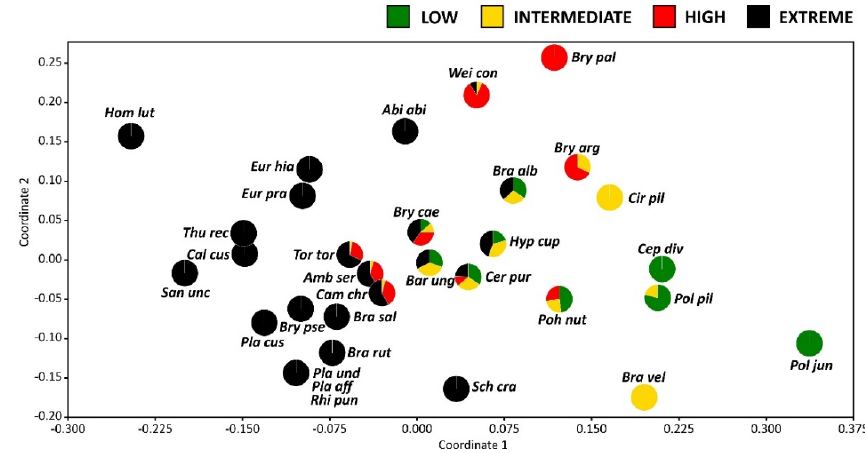
Figure 5. Non-metric multidimensional scaling (NMDS) scatterplot presenting similarities in terms of bryophyte species occurrence in the studied plots. The pie charts present the proportions of the occurrence of a given species in particular soil condition classes (based on a matrix of the frequency of a species in a given class). The abbreviations for the species are as follows: Abi abi — Abietinella abietina ; Amb ser — Amblystegium serpens ; Bar ung — Barbula unguiculata ; Bra alb — Brachythecium albicans ; Bra vel — Brachythecium velutinum ; Bry arg — Bryum argenteum ; Bry cae — Bryum caespiticium ; Bry